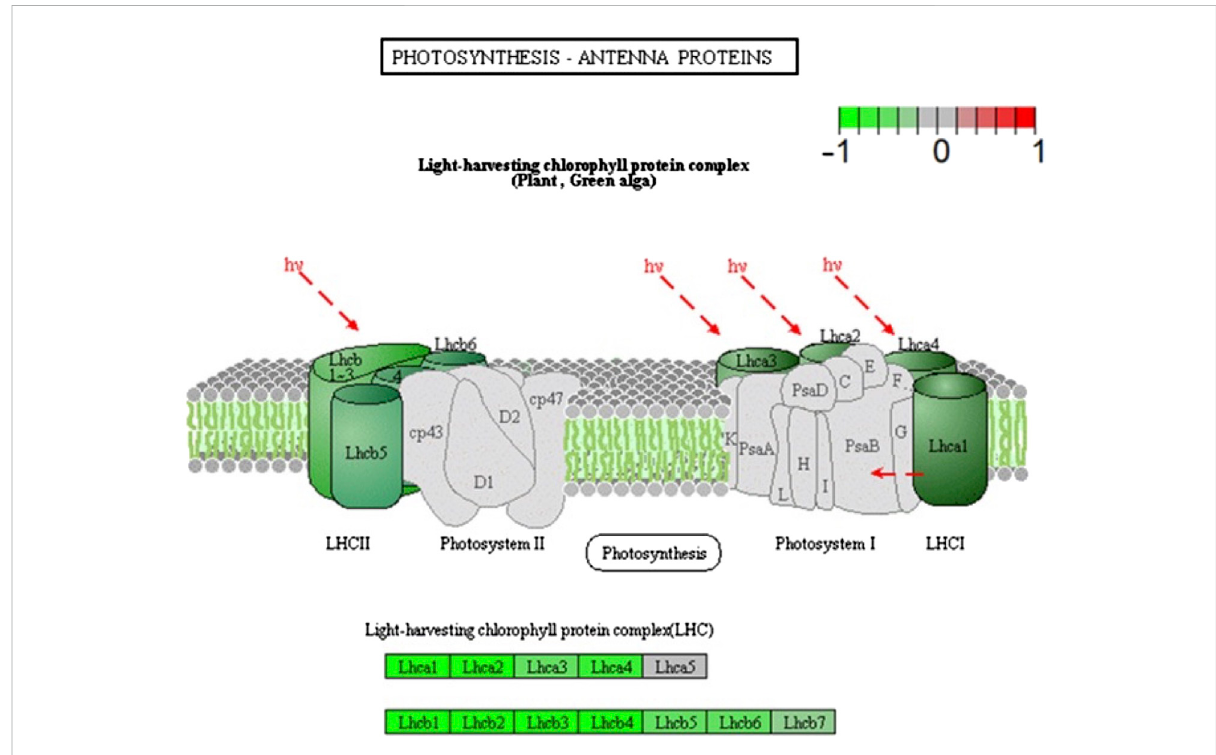
FIGURE 2 A diagram of PSI and PSII indicating the differential repression observed in microgravity and blue light. The brighter the green coloration, the more strongly the gene encoding the subunit was repressed. Modi fi ed from Vandenbrink et al.